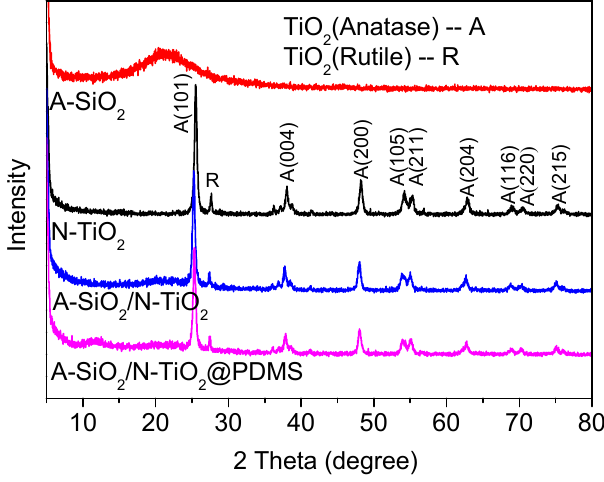
Figure 8. XRD patterns of A-SiO 2 , N-TiO 2 , A-SiO 2 /N-TiO 2 , and A-SiO 2 /N-TiO 2 @PDMS.